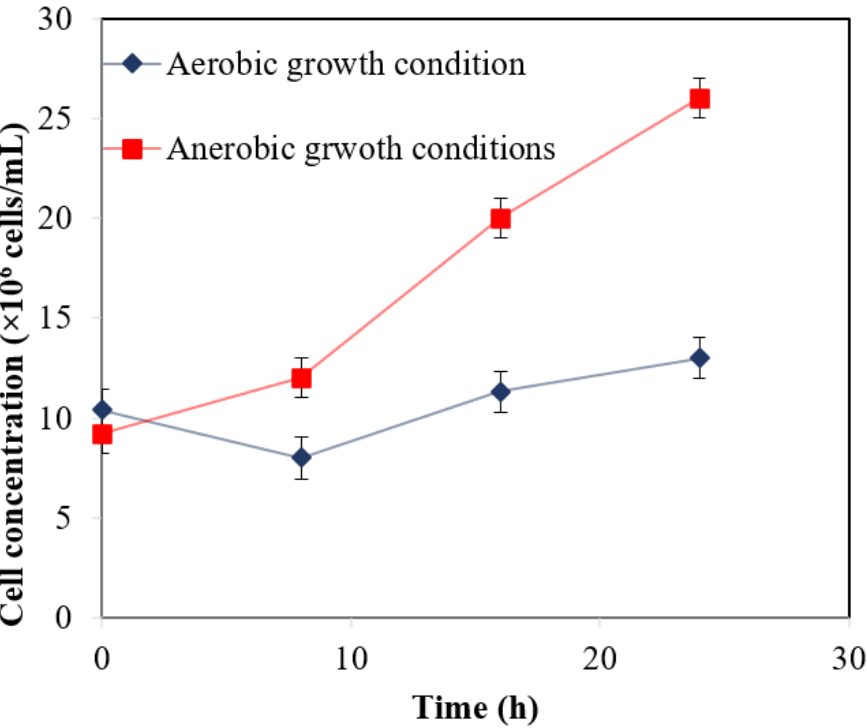
Figure 7. CbCt Cell count for samples grown in aerobic conditions compared with sample grown in anaerobic conditions.